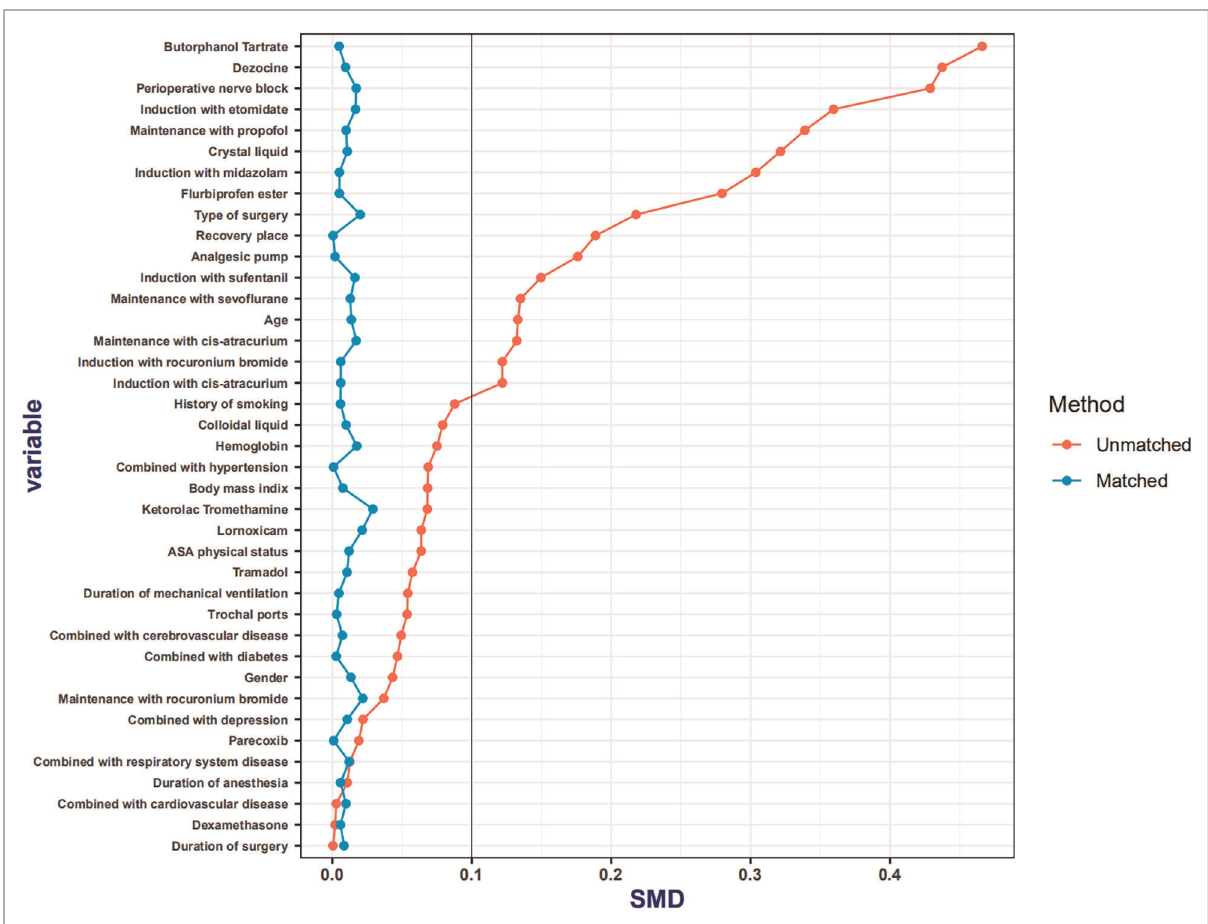
FIGURE 1 The absolute standardized mean differences in baseline characteristics between the two groups. The absolute standardized mean differences in all the baseline characteristics between the two groups were